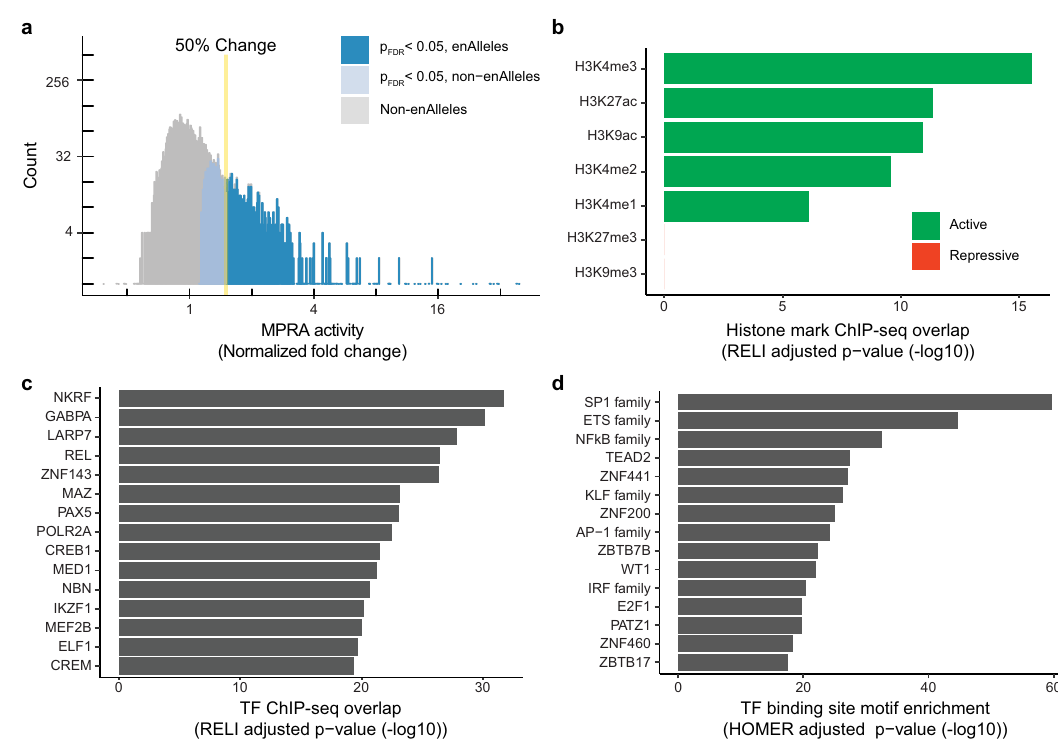
Fig. 2 Regulatory activity of enhancer variants (enVars). a Distribution of MPRA regulatory activity. The normalized fold change of MPRA activity relative to plasmid control ( X -axis) was calculated using DESeq2 ( n = 3 biological replicates). Enhancer alleles (enAlleles) (blue) were identi fi ed as those alleles with signi fi cant activity relative to control ( p adj < 0.05) and at least a 50% increase in activity (see “ Methods ” ). The p -values were generated by two-sided Wald tests with Benjamini – Hochberg multiple testing correction. Full results are provided in Supplementary Data 6. b Enrichment of histone marks in GM12878 cells at enVars compared to non-enVars. p -values were estimated by one-sided z-test with Bonferroni multiple testing correction using RELI (see “ Methods ” ). Full results are provided in Supplementary Data 9. c Enrichment of regulatory protein and transcription factor (TF) binding at enVars compared to non-enVars. p -values were estimated by one-sided z-test with Bonferroni multiple testing correction using RELI (see “ Methods ” ). The top 15 TFs (based on RELI p -values) that overlap at least 10% of enVars are shown. Full results are provided in Supplementary Data 9. d TF binding site motif enrichment for enVars compared to non-enVars. p -values were estimated by one-sided hypergeometric test with Benjamini – Hochberg multiple testing correction by HOMER using the full oligo sequences of enVars and non-enVars (see “ Methods ” ). The top 15 enriched TF motif families are shown. Full results are provided in Supplementary Data